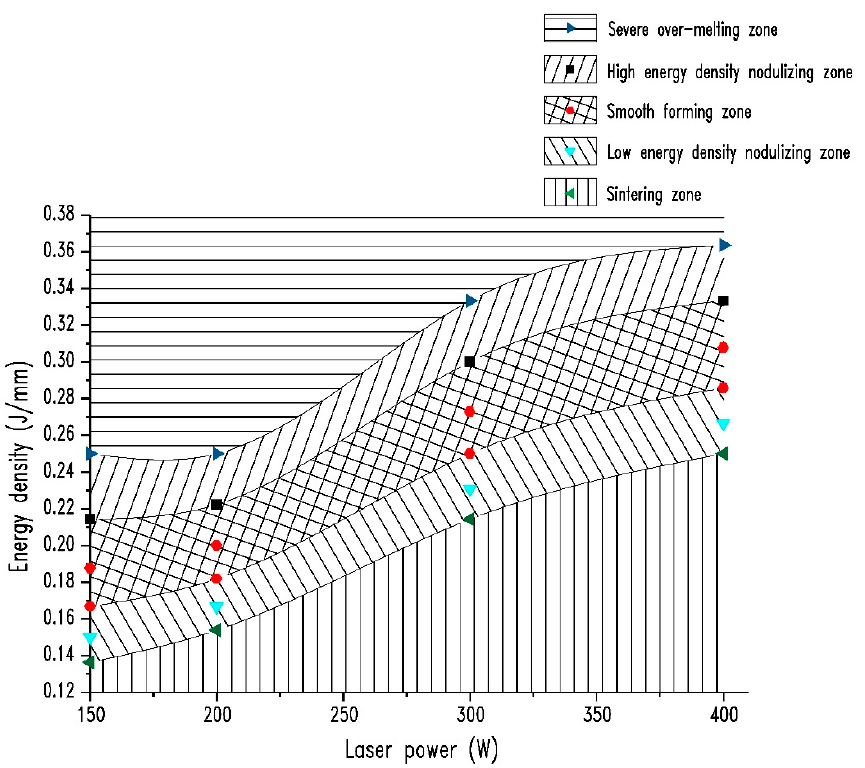
Figure 5. Formation zones in energy density vs. energy input.